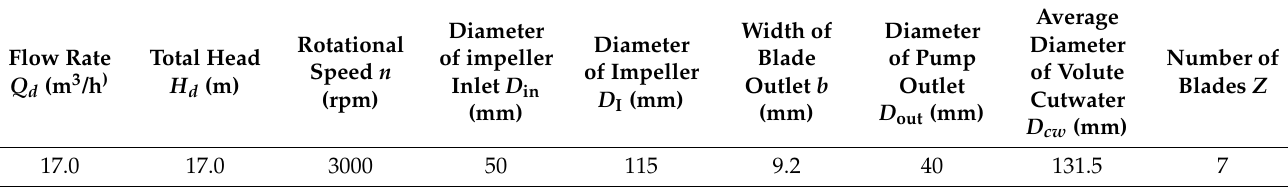
Table 2. Parameters of the centrifugal pump.